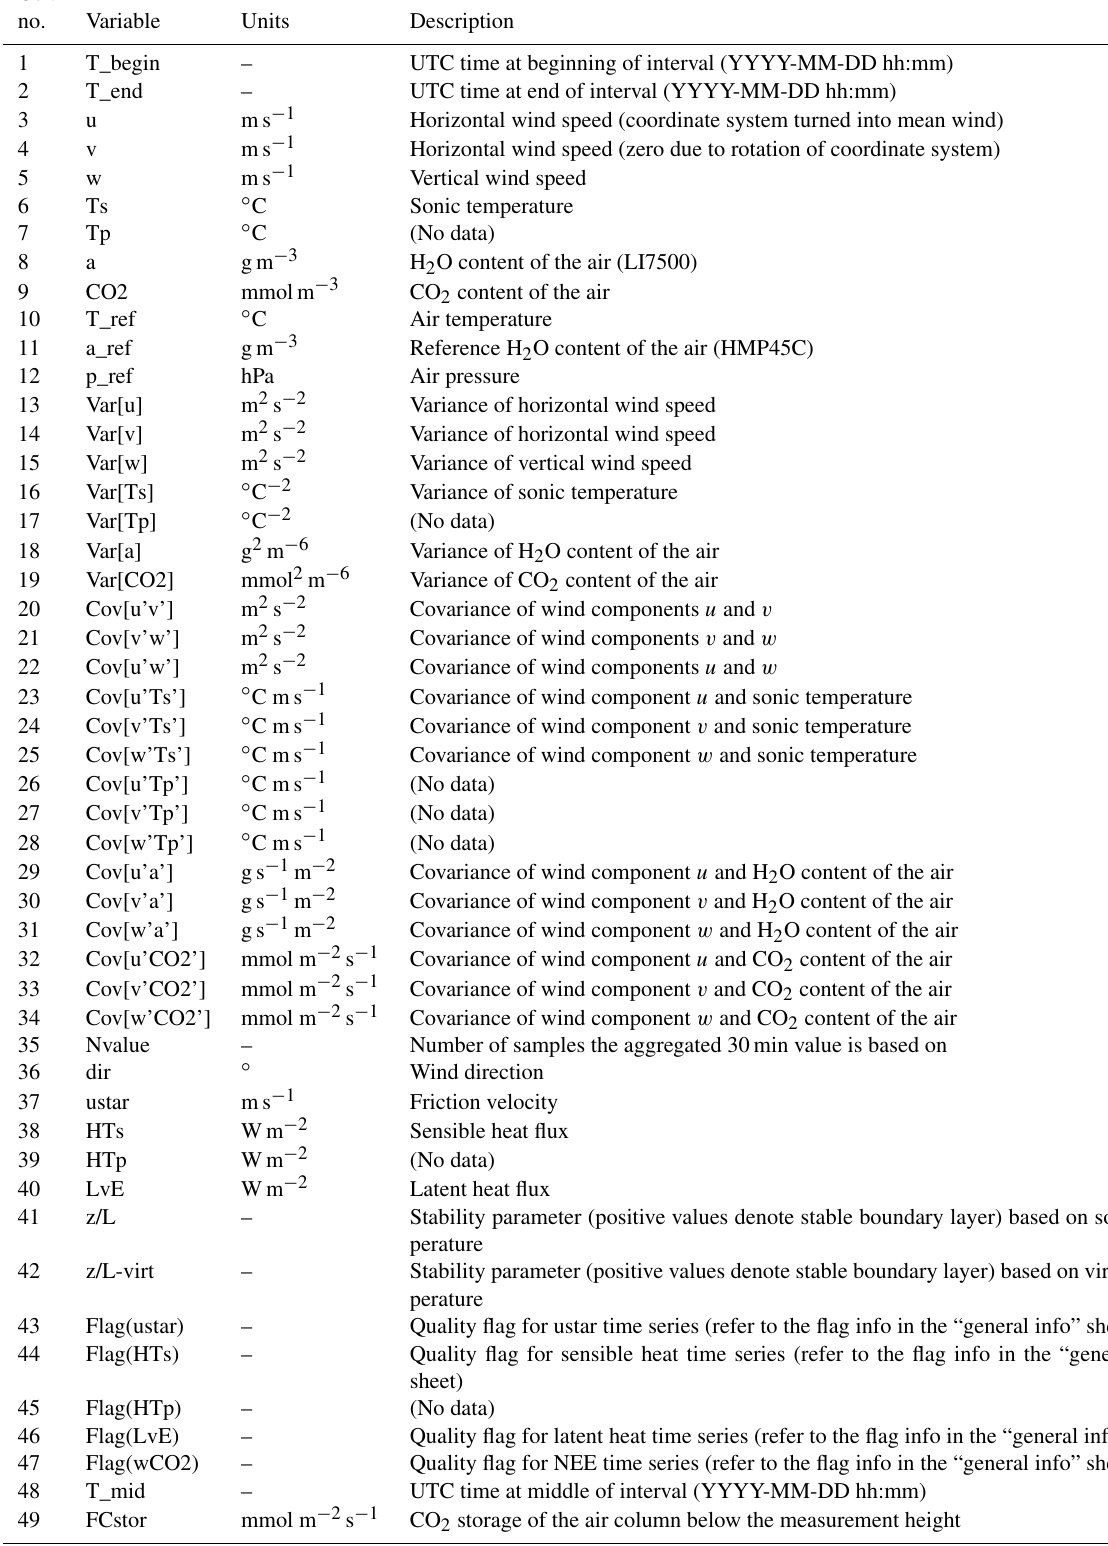
Table A3. Columns of flux data files processed with the software TK. With the exception of the timestamps, all data types are numeric.